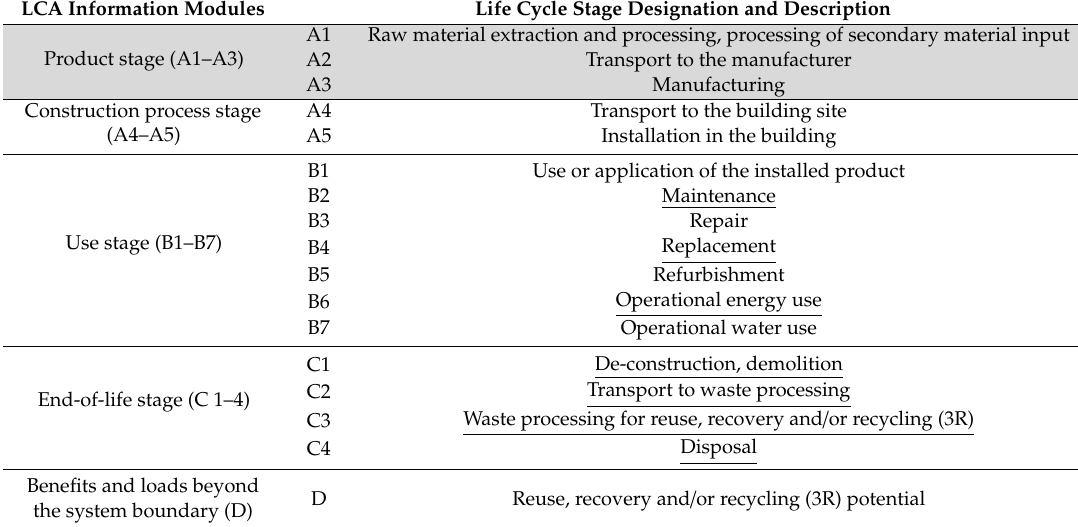
Table 3. Detailed description of the life cycle stages of building materials modules (assessed in this research—highlighted in grey; only discussed—underlined)